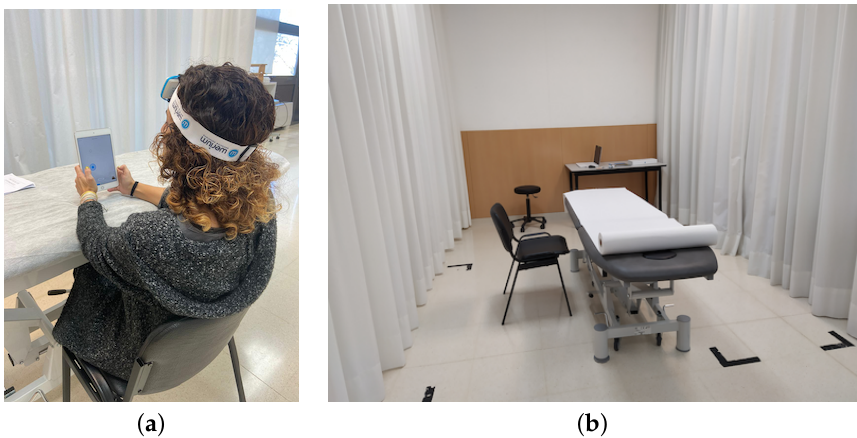
Figure 10. ( a ) Subject of the experiment playing the exergame in ( b ) the experiment